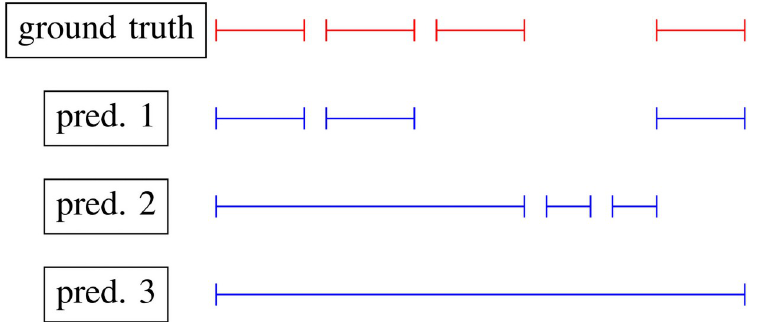
Fig 7. Example of three possible predictions (blue) in accordance with the existing ground truth (red). Every line segment represents a pupil